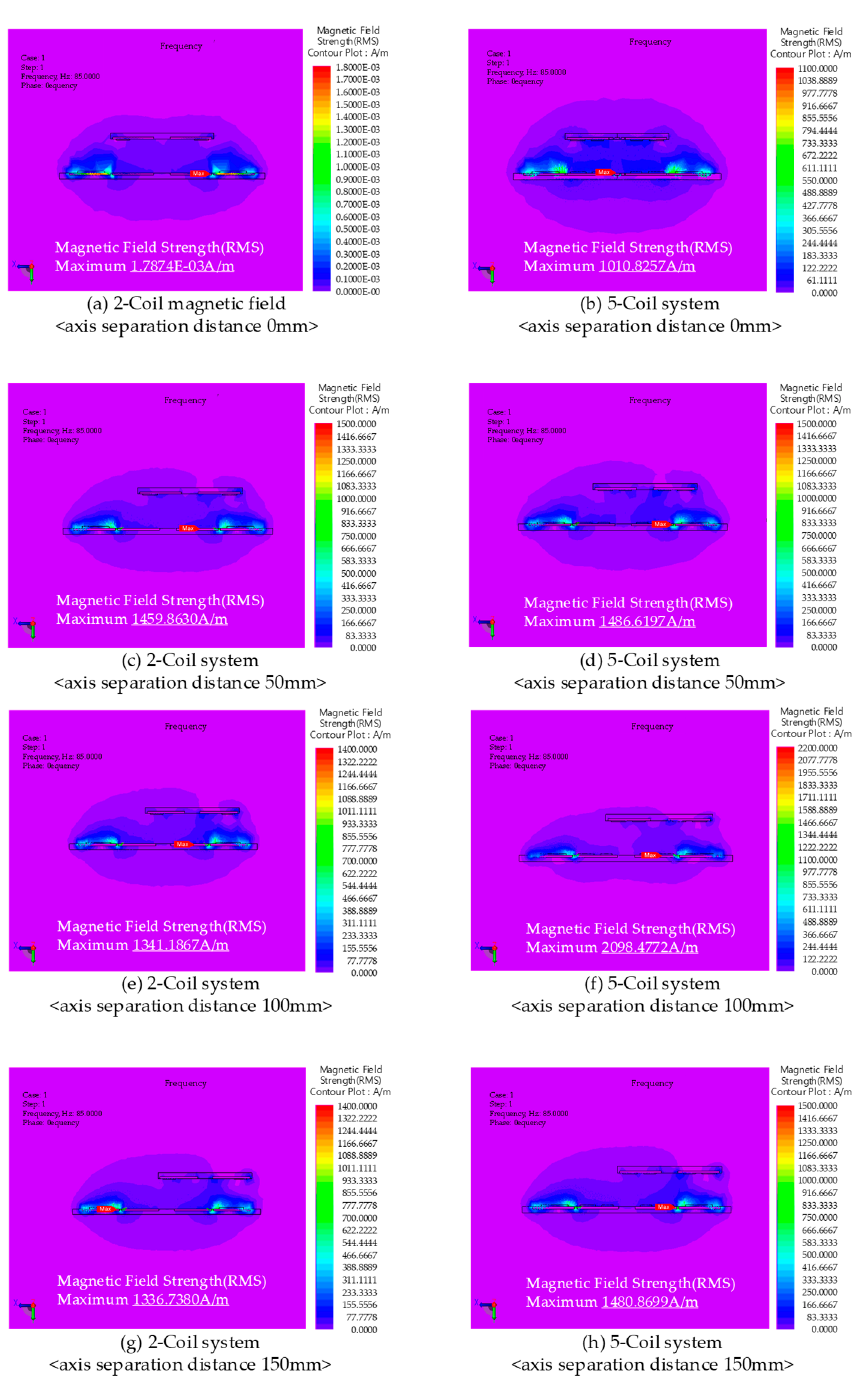
Figure 21. Magnetic fi eld strength of the coil system.